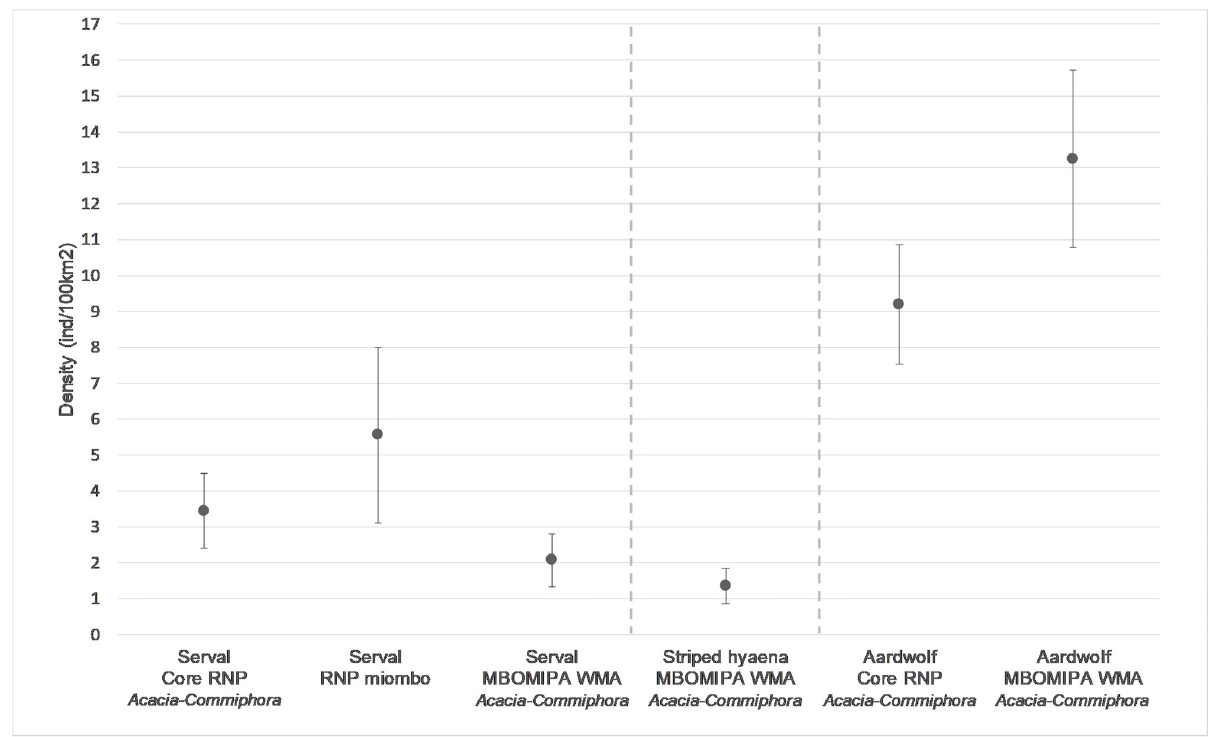
Fig 2. Population density estimates for the target species at the three survey sites. Bars represent standard errors.